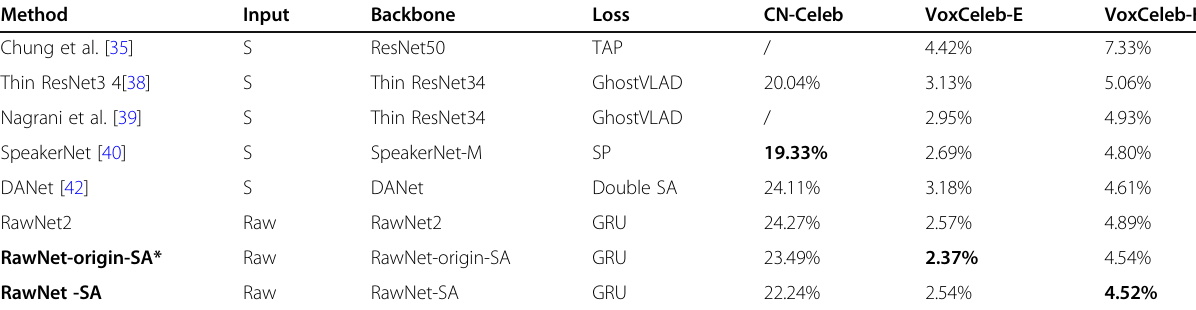
Table 3 Results of comparison to state-of-the-art method on VoxCeleb-E and VoxCeleb-H evaluation protocols